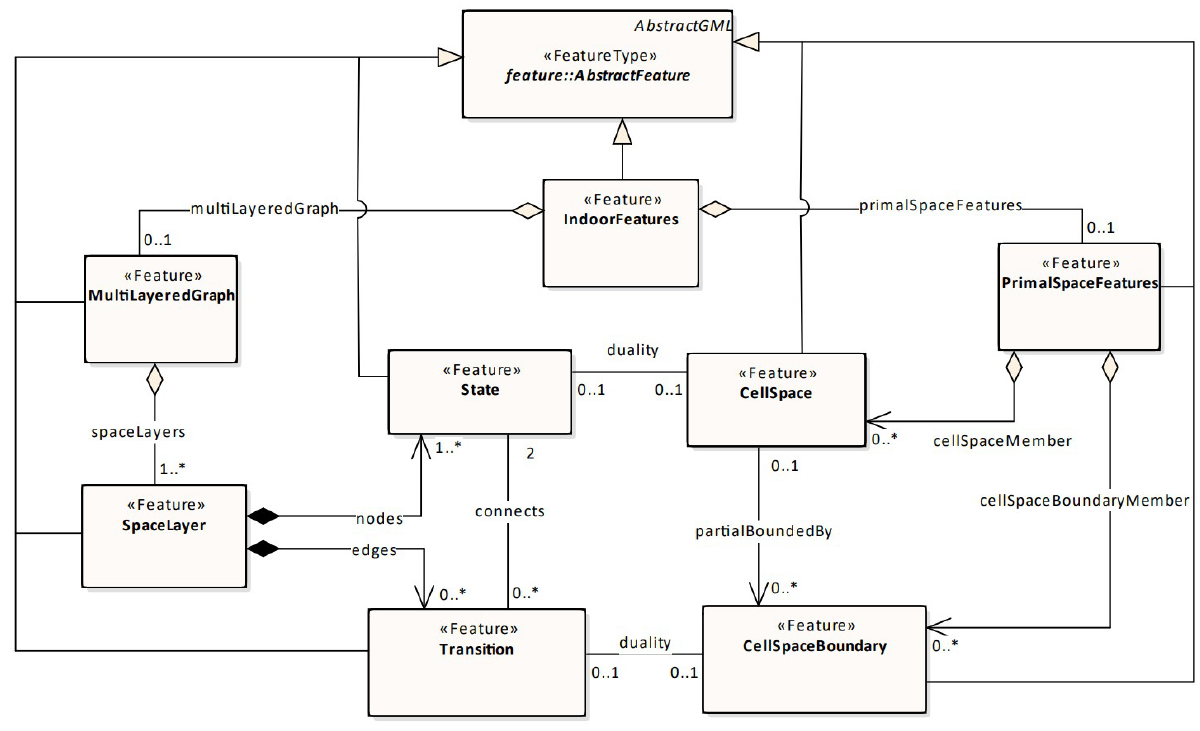
Figure 3. UML of the IndoorGML data model